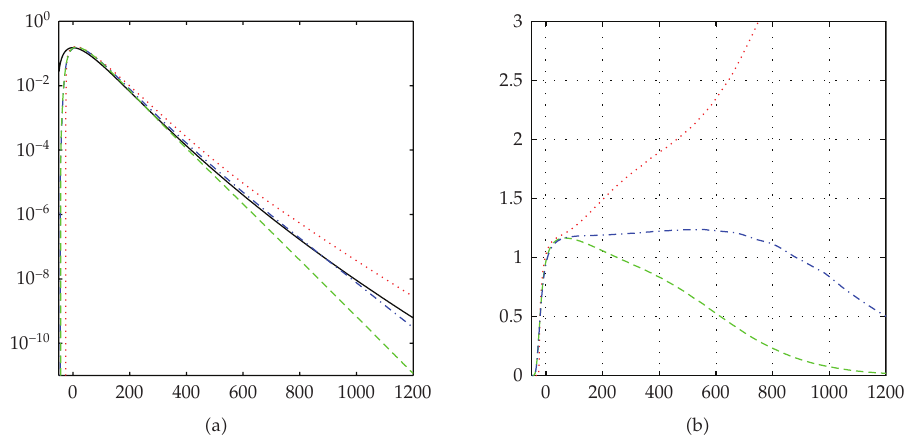
(cid:2) u (cid:3) computed using the proposed hybrid method: sample N (cid:2) u (cid:3) /μ s (cid:2) u (cid:3) N